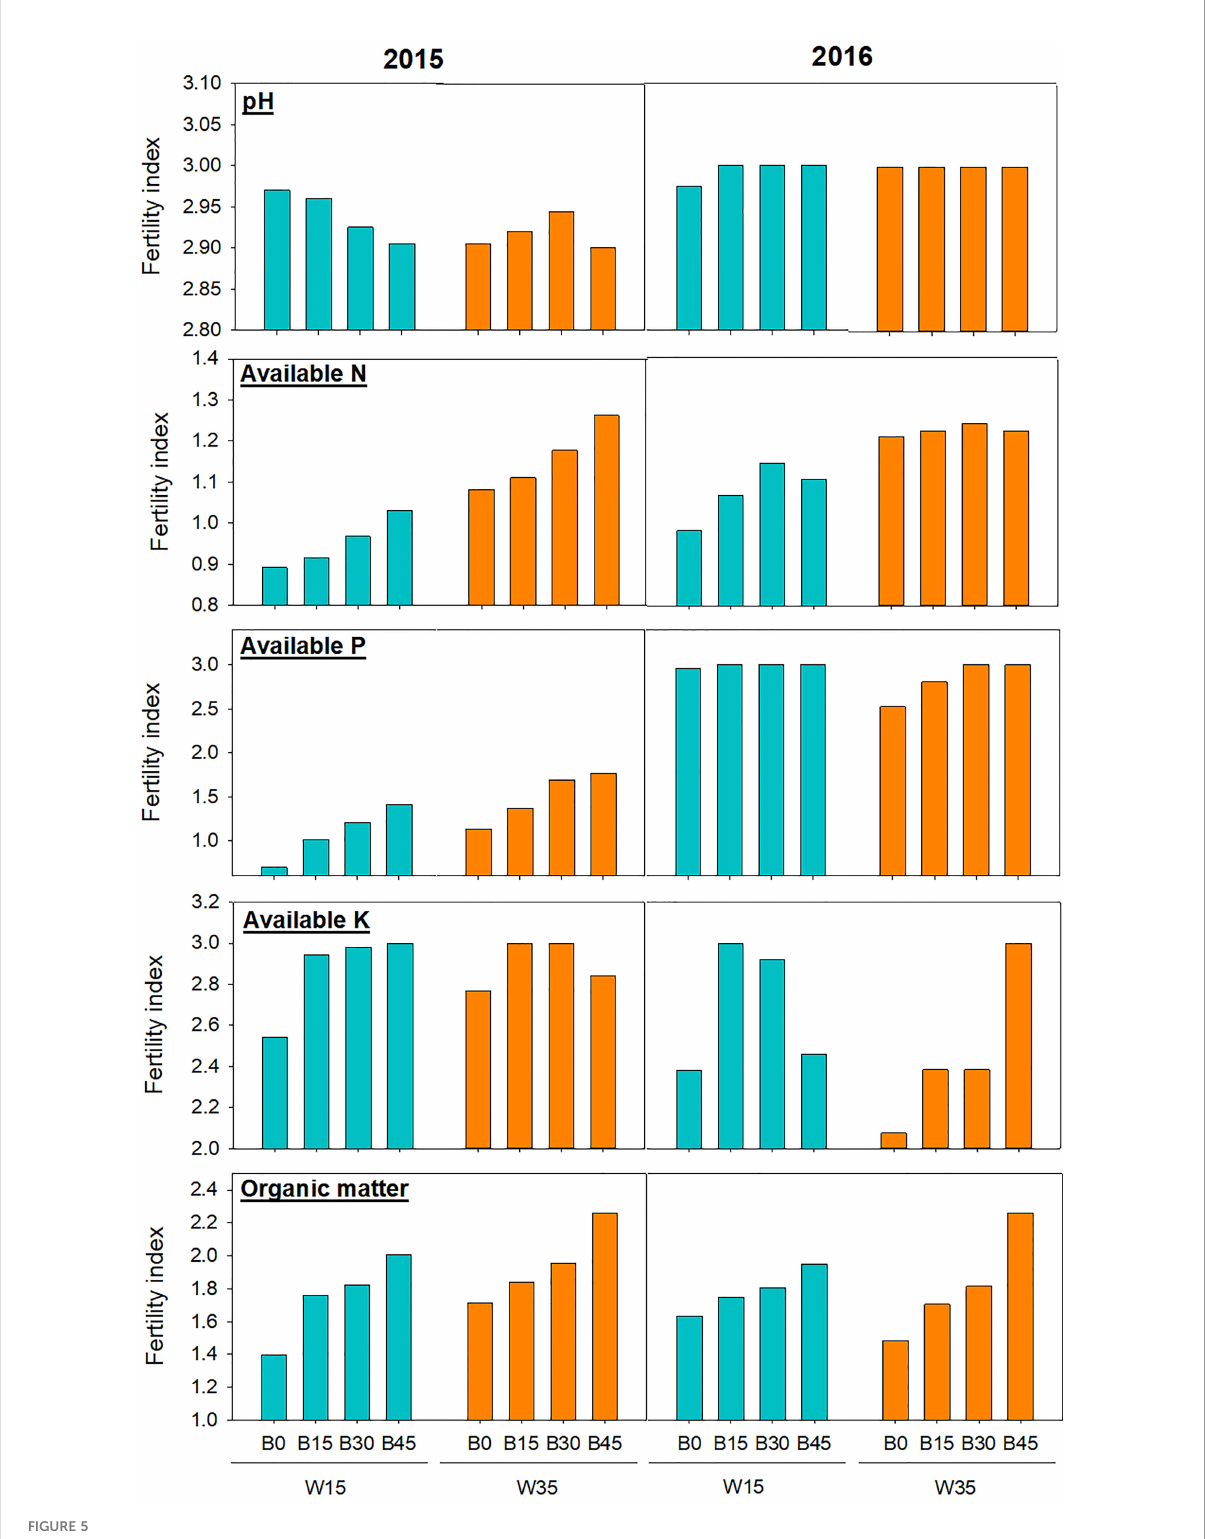
FIGURE 5 Soil fertility index for the individual variable (pH, available nitrogen (AN), available phosphorus (AP), available potassium (AK), and organic matter (OM) in the top 15-cm soil layer during maize physiological maturity stage at biochar application rates (0 (B0), 15 (B15), 30 (B30), and 45 (B45) t ha -1 ) applied in irrigation water lower limits at soil matric potential -15 (W15) and -35 kPa (W35) each year. Different lowercase represents signi fi cant difference at P<0.05 between